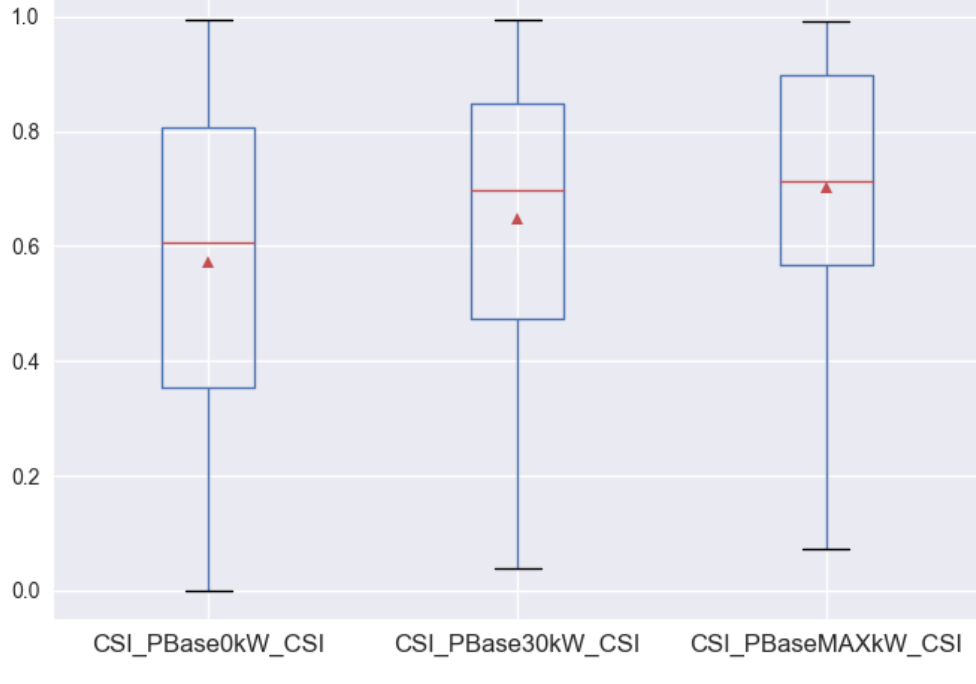
Figure 10. Boxplot of yearly CSI statistics for different values of P Base in the CSI-sensitive scenario. Note that only charging processes with a CSI value of less than 1.0 are reflected